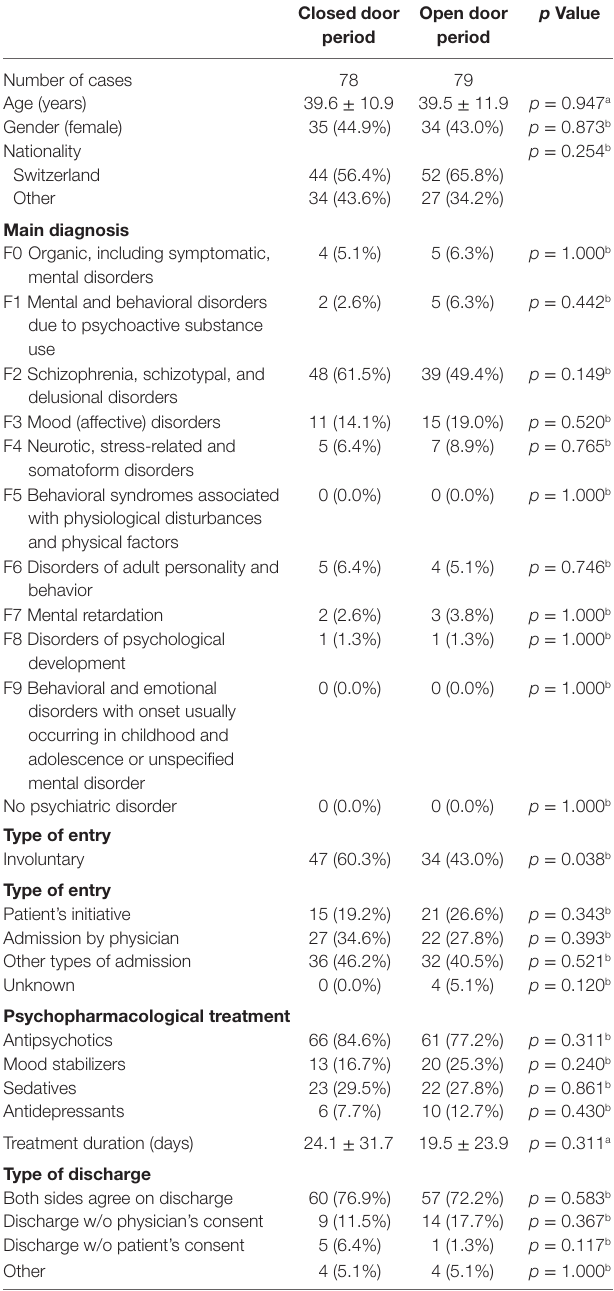
TaBle 1 | Clinical and sociodemographic characteristics of cases admitted to the PICU before and after the introduction of predominantly open doors ( N =